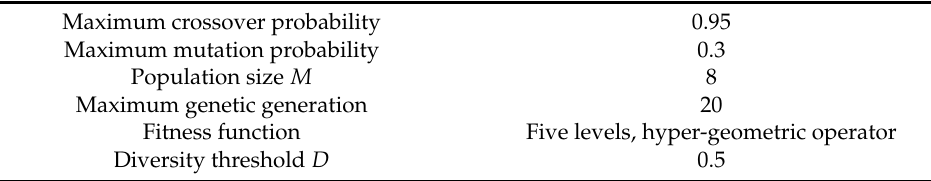
Table 1. Settings for the algorithm